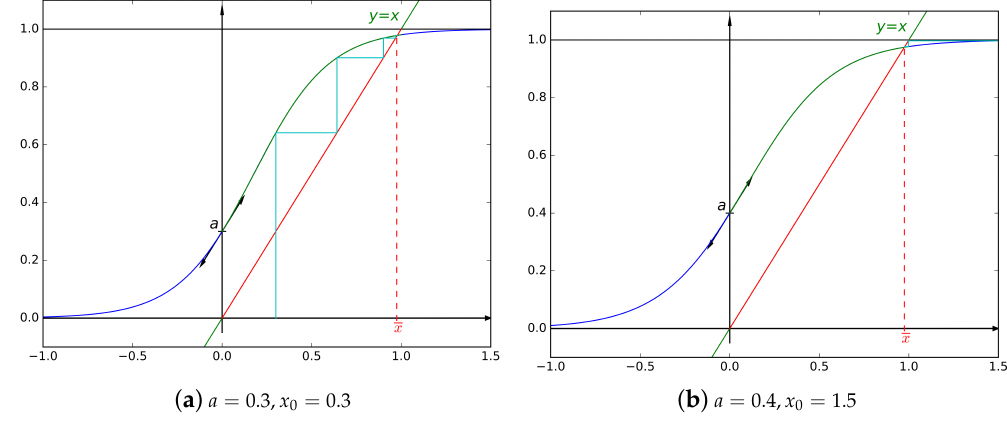
Figure 10. Iterations of x n + 1 = f a ( x n )